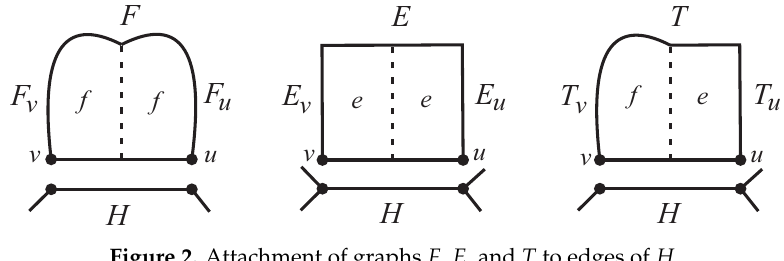
Figure 2. Attachment of graphs F , E , and T to edges of H